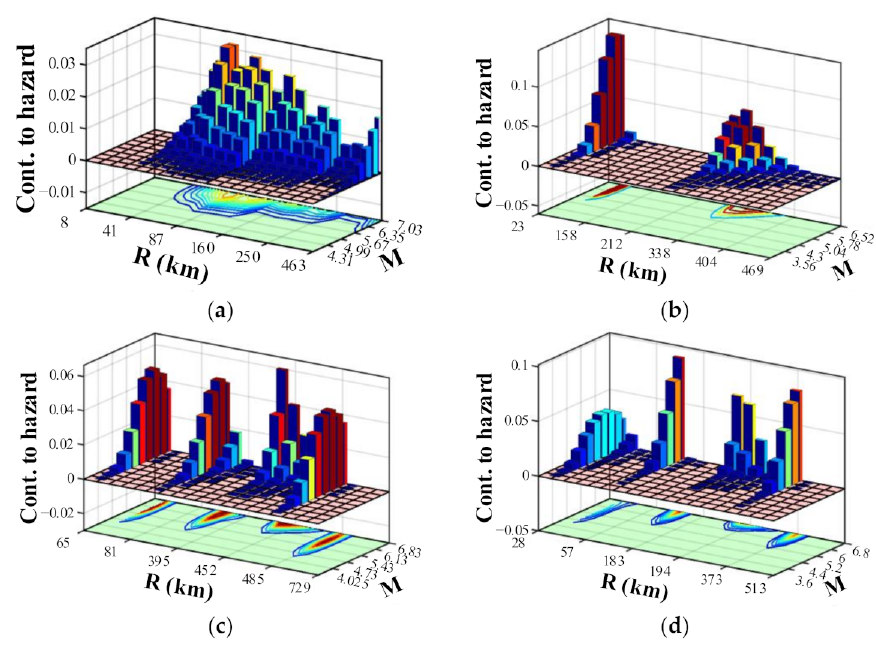
Figure 12. Deaggregation plot for most contributing earthquake range selections from four seismic source model in Korea; ( a ) Model A, ( b ) Model B, ( c ) Model C and ( d ) Model D.